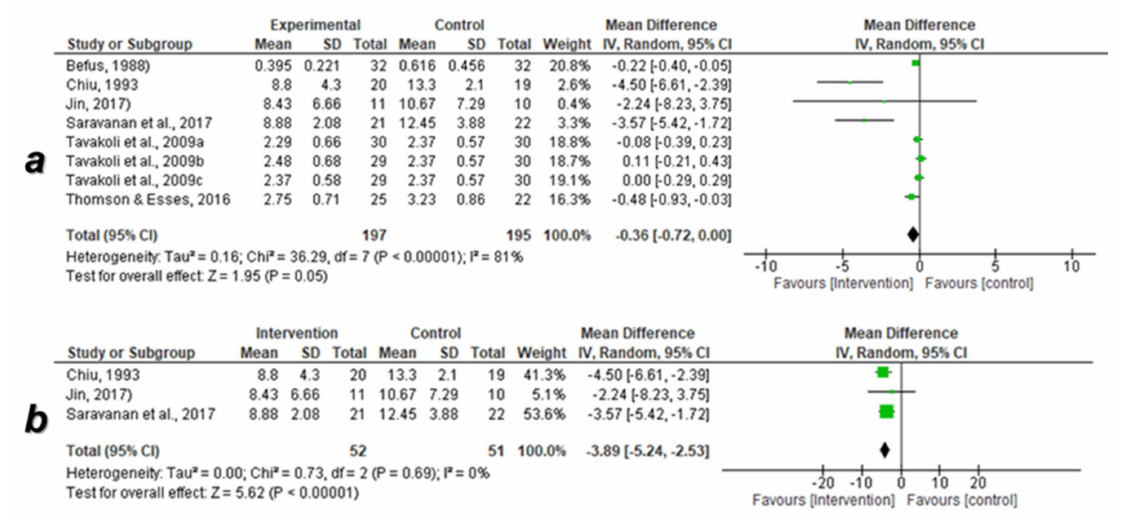
Figure 4. Forest plot of the meta-analysis of the data of acculturative stress. ( a ) Before application of sensitivity test, ( b ) after application of sensitivity test, I 2 : heterogeneity, CI: confidence interval, SD: standard deviation, P: p -value. Black diamond denotes the overall effect size, green color denotes the central point of the confidence interval. The RCT by Tavakoli et al. (2009) [48] was subdivided into three studies (Tavakoli et al., 2009a, 2009b and 2009c) because it contains three different interventions (assertive training, expressive writing, and a combination of the two methods) versus the same con-troll